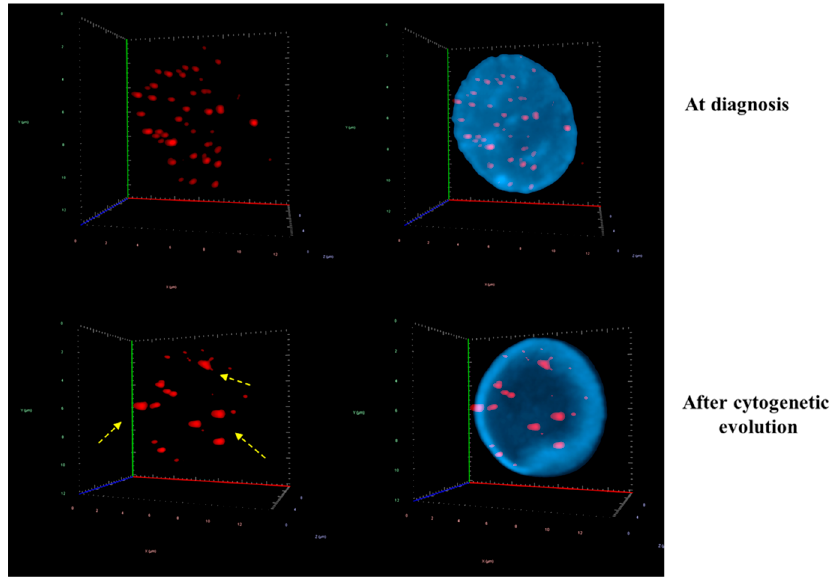
Figure 3. Evolution of 3D nuclear architecture during the MDS disease course. The left side shows representative 3D nuclear telomere distribution (red) within the counterstained nucleus (blue). During cytogenetic evolution, the 3D nuclear architecture undergoes distinct changes: The number of signals decrease and the number of telomere aggregates increase. The yellow dashed arrows indicate telomere aggregates (for details, see text and Supplementary Table S1 (Patient number 1).